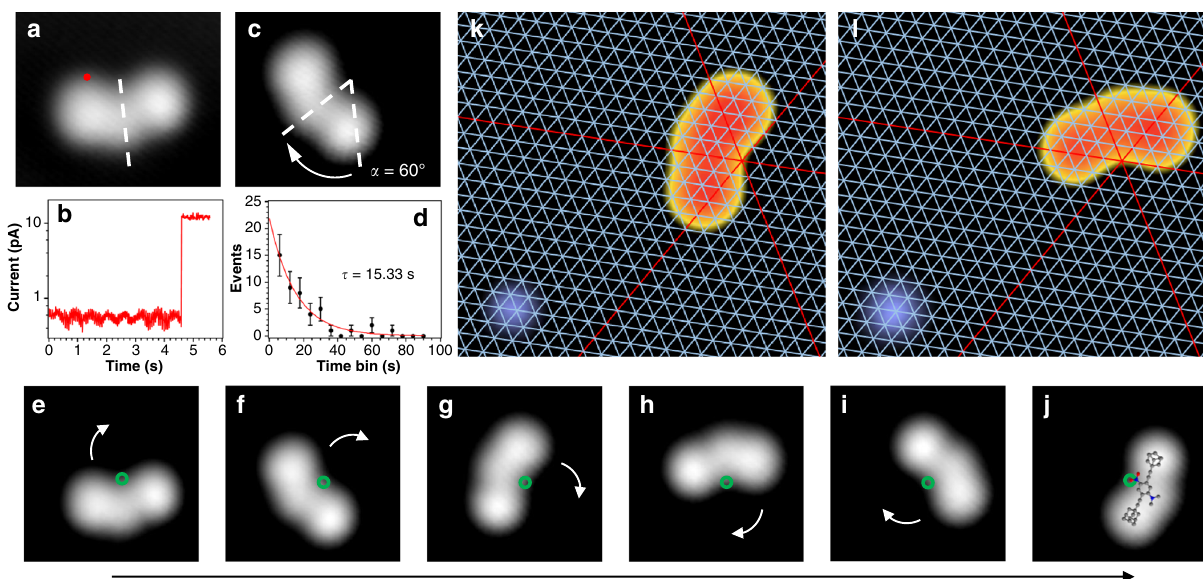
Fig. 2 Controlled rotation of single molecules. STM images (1.03 V, 0.27 pA) before ( a ) and after ( c ) a voltage pulse ( + 1.31 V at the position marked in red). b Current recorded as a function of time with open feedback loop during the pulse in a . The step corresponds to a rotation of the molecule. d Poisson distribution of times t before a rotation occurred, fi tted with A (cid:3) e (cid:4) t = τ (error bars represent the standard deviation). e – j Series of consecutive STM images (1.03 V, 0.27 pA) with a complete clockwise rotation (counter-clockwise rotation in Supplementary Fig. 9) by voltage pulses with the tip always in the very same position with respect to the molecule (indicated in a by a red dot), thus in six positions with respect to the surface. k – l STM images (0.70 V, 0.27 pA) of a molecule before and after rotation ( α = 60°) with CO molecule (blue, lower left) as reference point. The point of intersection of the red lines indicates a top site of the Ag(111) surface as pivot point (marked green in e – j image was simulated (Fig. 1g) that correlates well to the experimental result. One can identify that the adamantane groups re fl ect the two large lobes of the STM image while the dimethylamine is responsible for the asymmetric appearance, indicated by the arrow in Fig. 1d.